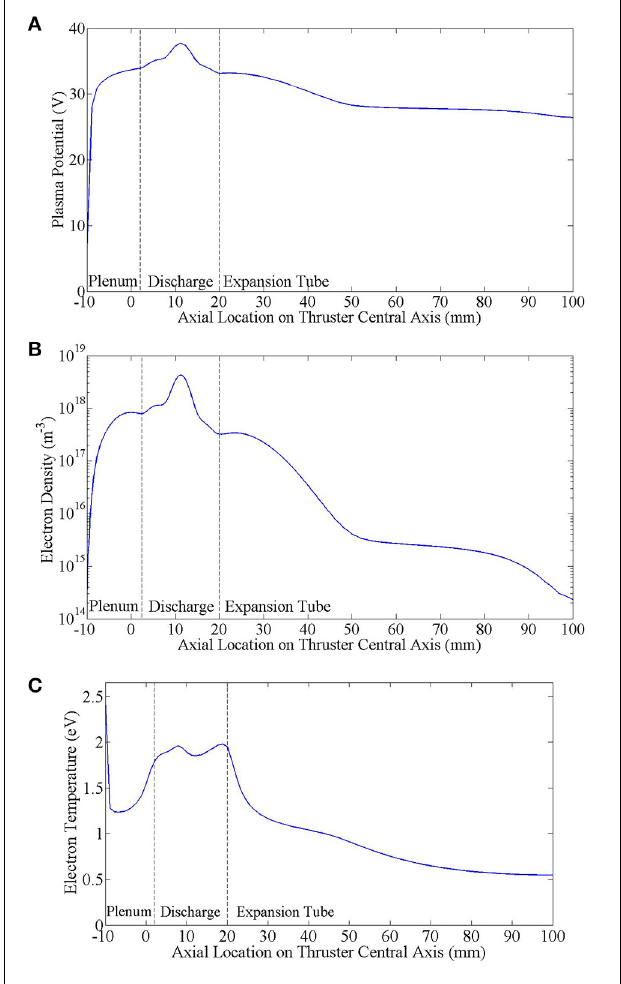
FIGURE 5 | Time averaged CFD simulation results for (A) plasma potential, (B) electron density and (C) electron temperature along the central axis, including the plenum chamber, discharge tube and expansion